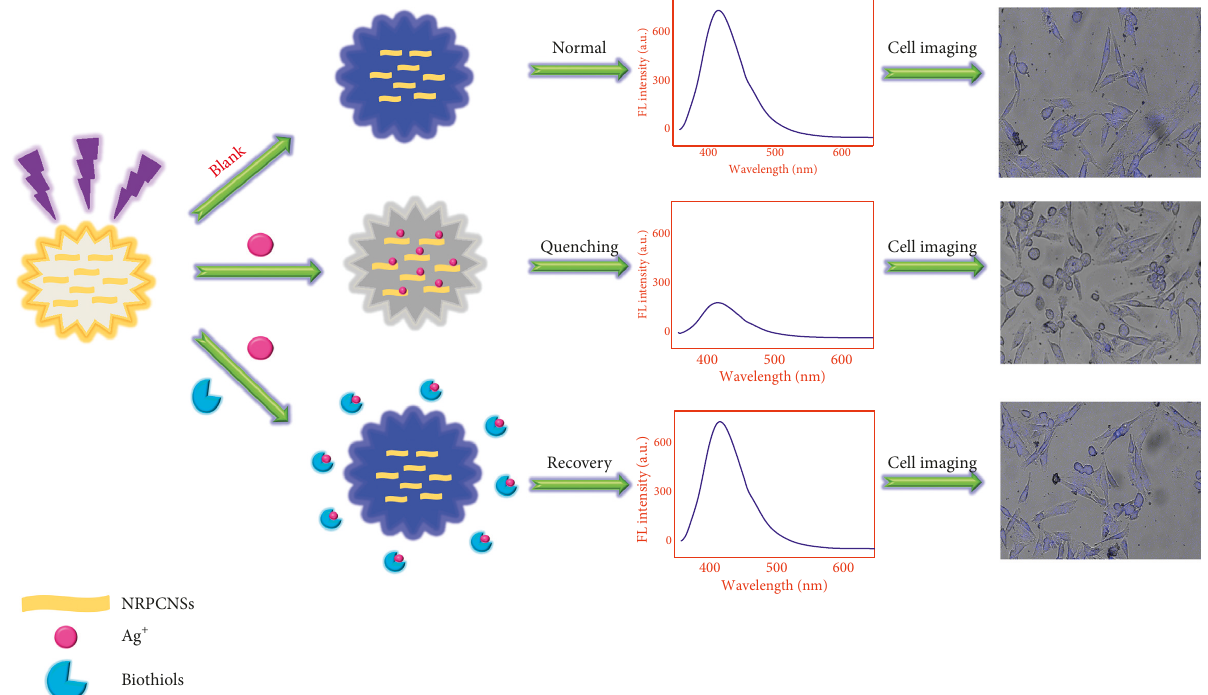
Scheme 1: Schematic diagram of the mechanism of the detection of biothiols by the fluorescent